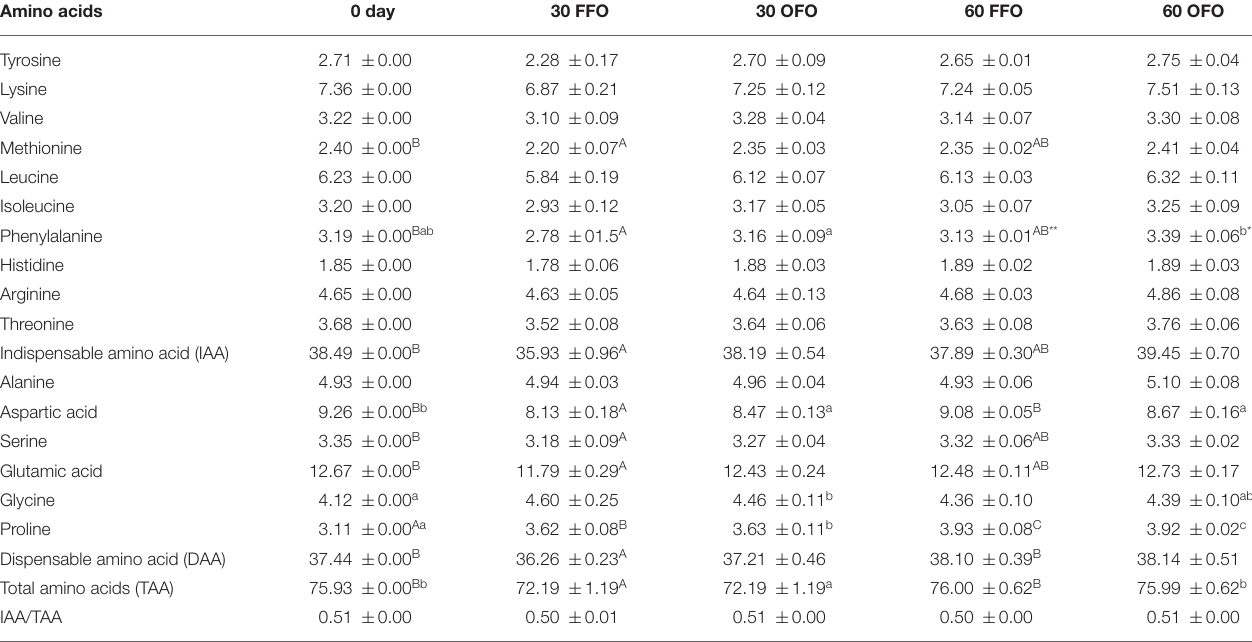
TABLE 4 | Muscle amino acids content of grouper fed different diets. Amino